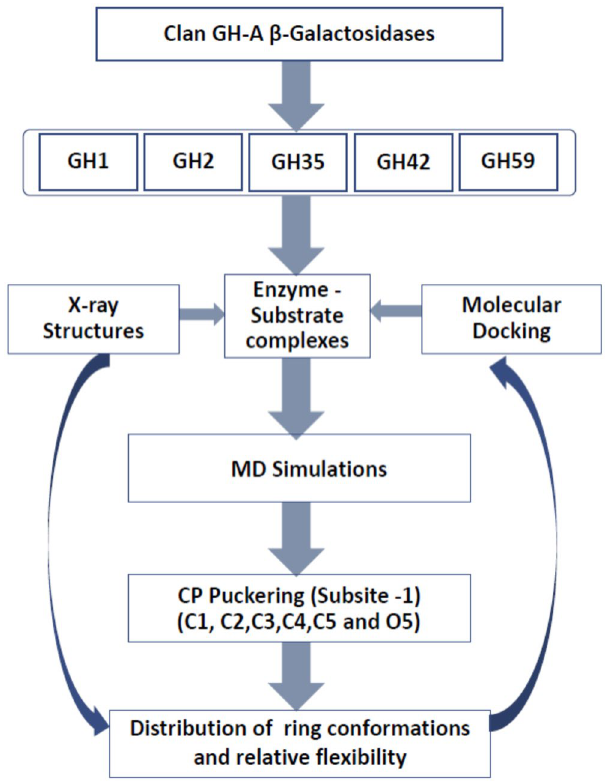
Figure 1. Flowchart of methodology adopted in this